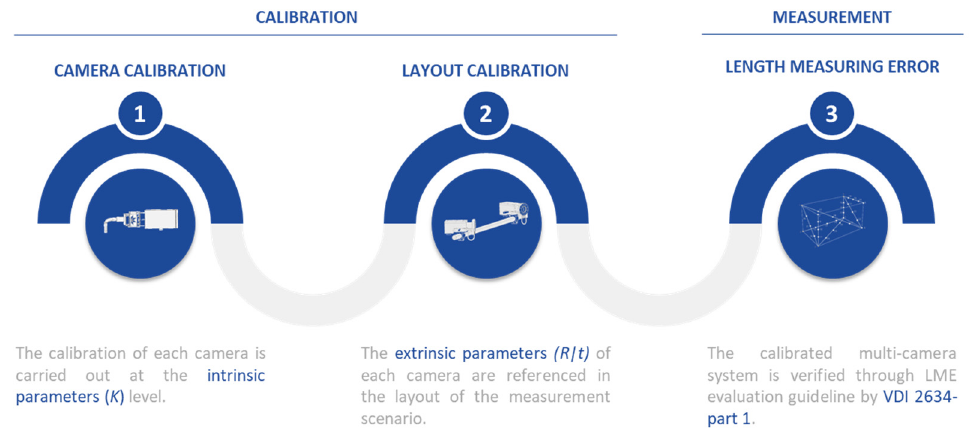
Figure 1. The calibration process of the muti-camera system is divided into two scenarios (camera calibration and measurement). The first scenario ( 1 ) is concerned with the camera calibration while the second one focuses on referring the layout frame ( 2 ). Finally, LME evaluation is carried out ( 3 ).